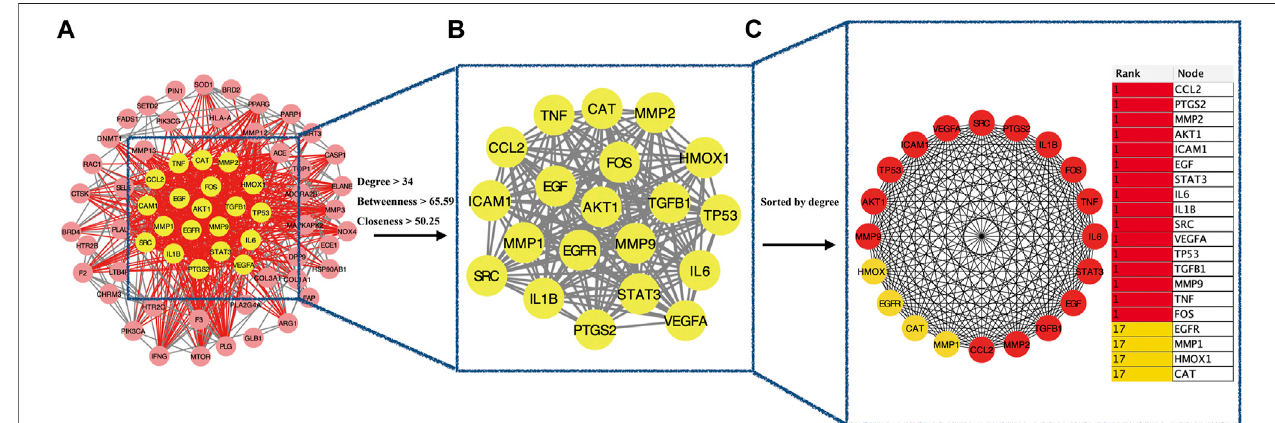
FIGURE4 | Identi fi cation ofcandidate targetsfor Convalescent Chinese prescription (CCP) against pulmonary fi brosis viaProtein – protein interactionAnalysis. (A) . Protein – protein interaction (PPI) networks of shared targets between Convalescent Chinese prescription (CCP) and pulmonary fi brosis were analyzed by STRING 11.0. (B) .Themostsigni fi cantmoduleidenti fi edbythetopologyselection(degreecentrality > 34,betweennesscentrality > 65.59,closenesscentrality > 50.2). (C) .Thecore20 targets (hub targets) in the PPI network ranked by degree centrality using the cytoHubba plug-in.